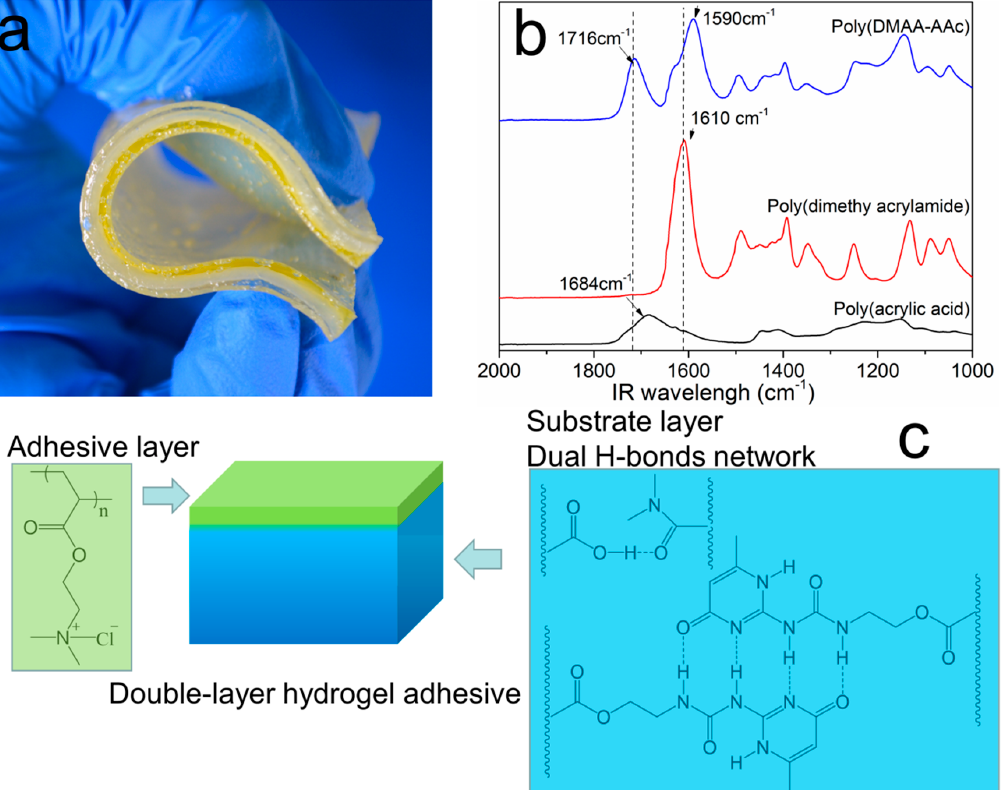
Figure 1. ( a ) Actual image of a DL hydrogel sample. The top adhesive layer was yellow-stained. ( b ) IR spectra of polyacrylic acid, poly( N , N -dimethyl acrylamide), and poly(DMAA-co-AA). ( c ) Schematic representation of dual hydrogen-bond